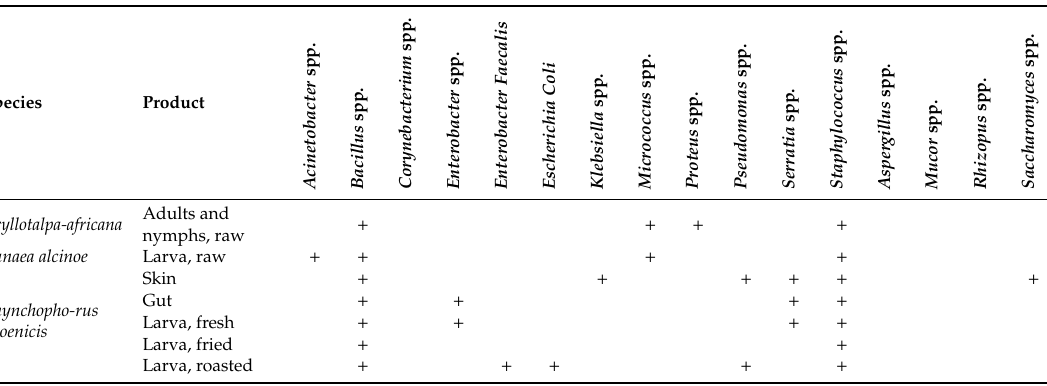
Table 1. Selection of microbiological findings in three African edible insect species (African mole cricket ( Gryllotalpa africana ), cabbage tree emperor moth ( Bunaea alcinoe ), and African palm weevil ( Rhynchophorus phoenicis )); based on [1]. Blank spaces either mean that the sample was negative for that pathogen or was not tested for